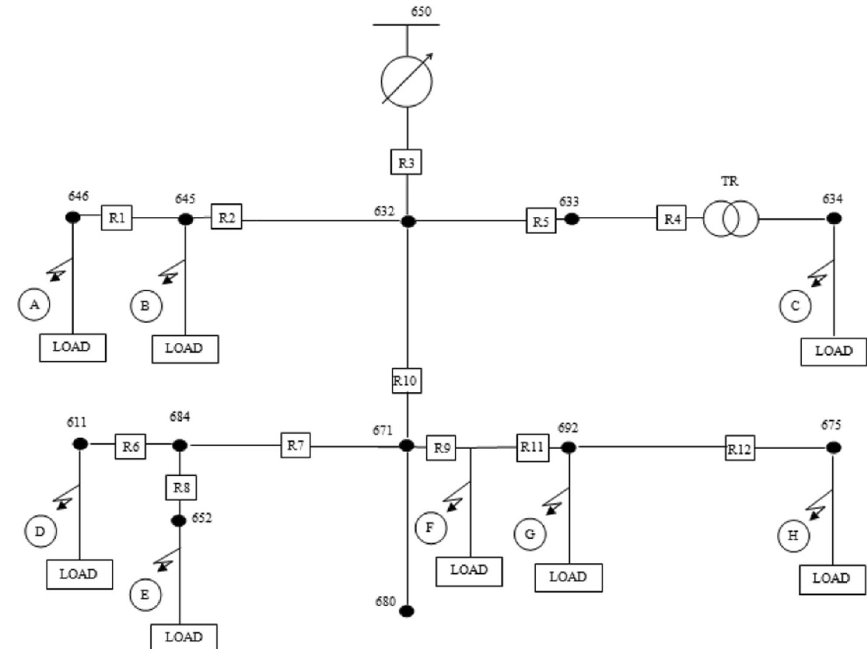
Fig. 1 Relay coordination diagram